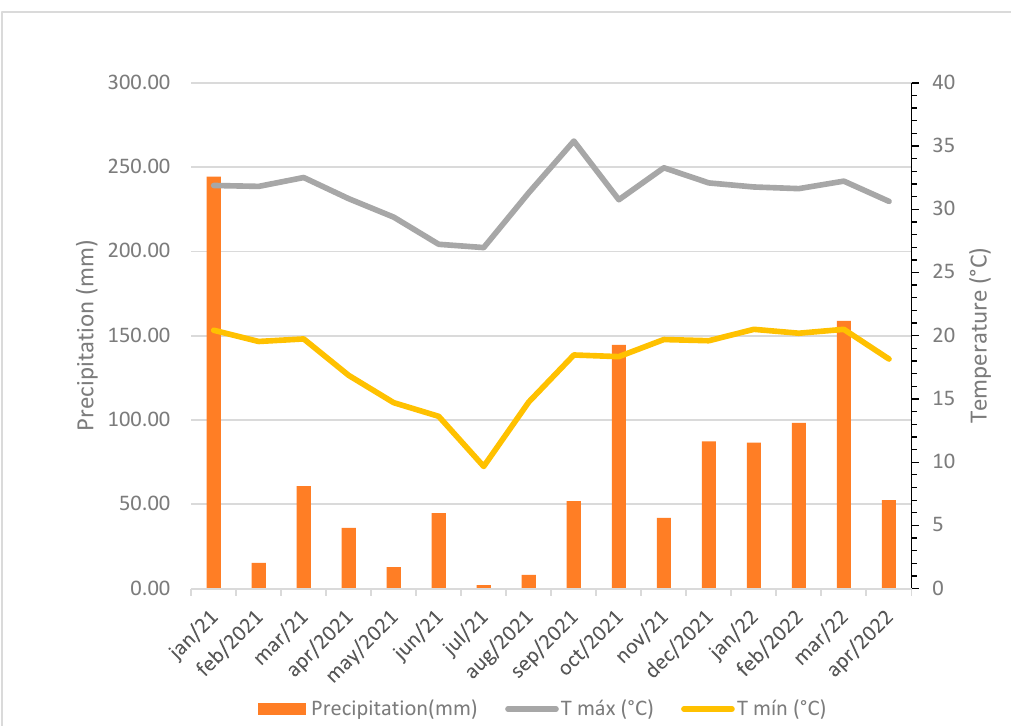
Figure 1. Maximum and minimum air temperature (°C) and monthly accumulated rainfall (mm) during the experiment from January 2021 to April 2022.